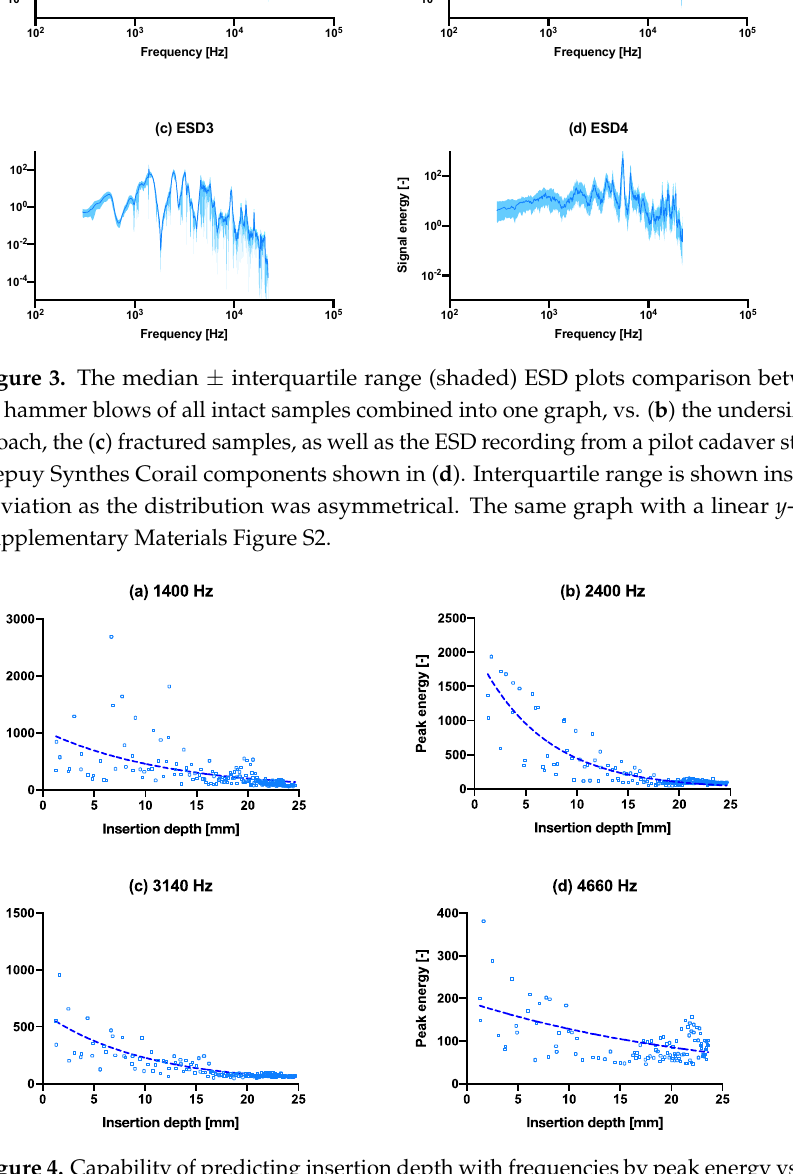
Exp. eqn. best-fit values